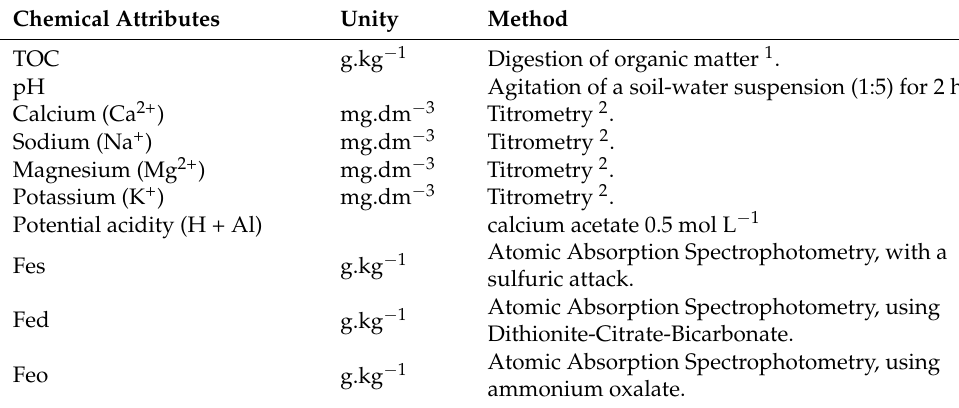
Table 3. Chemical characteristics of soils and their respective methods. Chemical